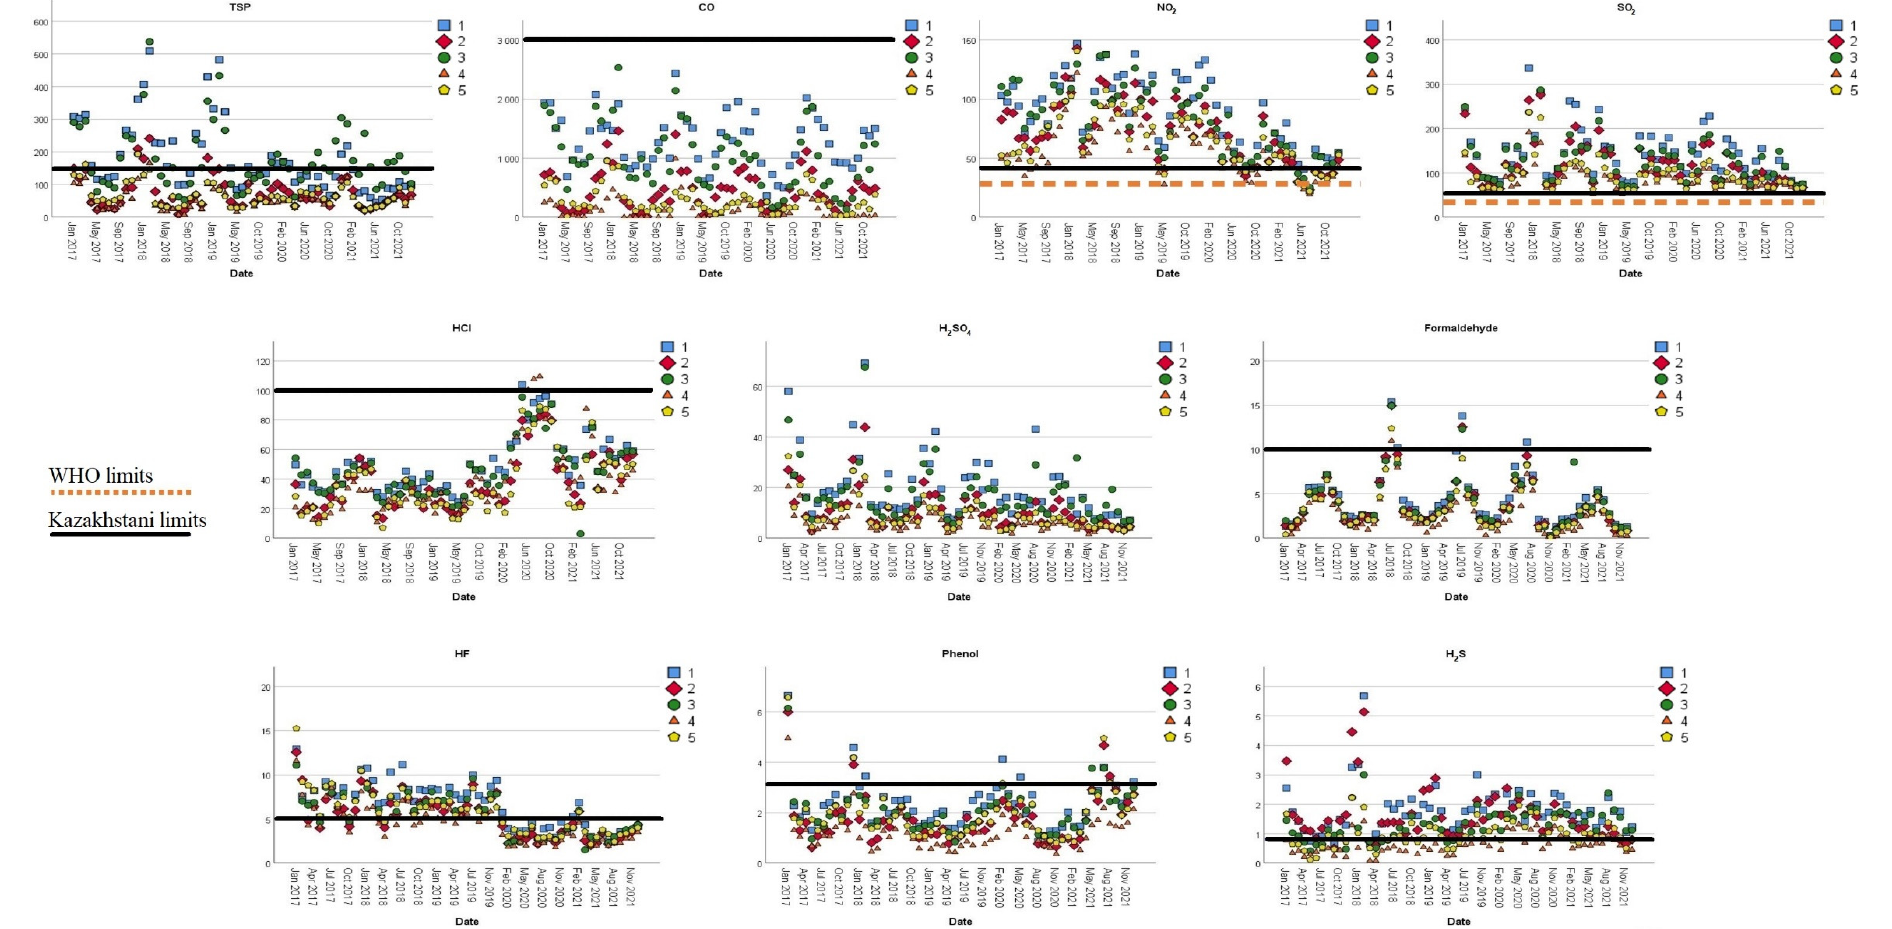
Figure 3. Temporal variations of the studied pollutants against WHO and Kazakhstani limits ( μ g m − 3 ).